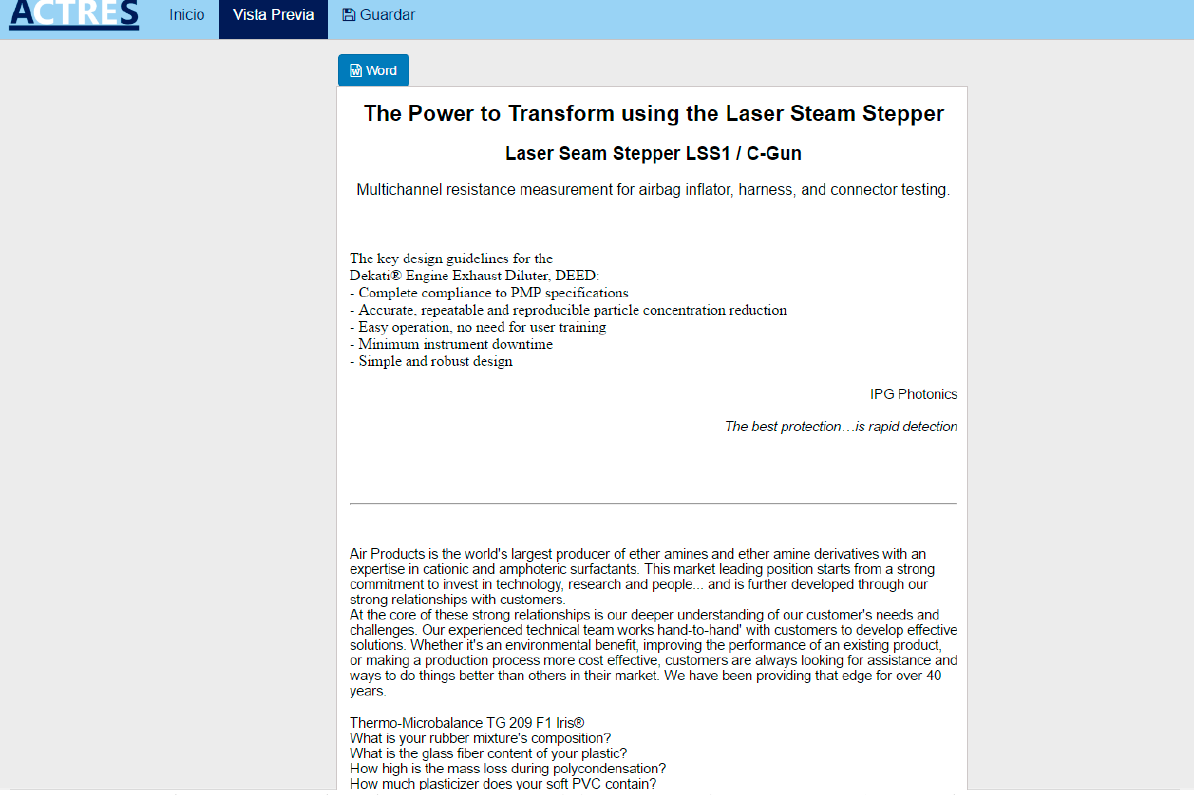
Figure 7. Final document produced with the O-WEAA’s Writing Assistant Interface Module A demo can be found at https://actres.unileon.es/demos/generadores2.